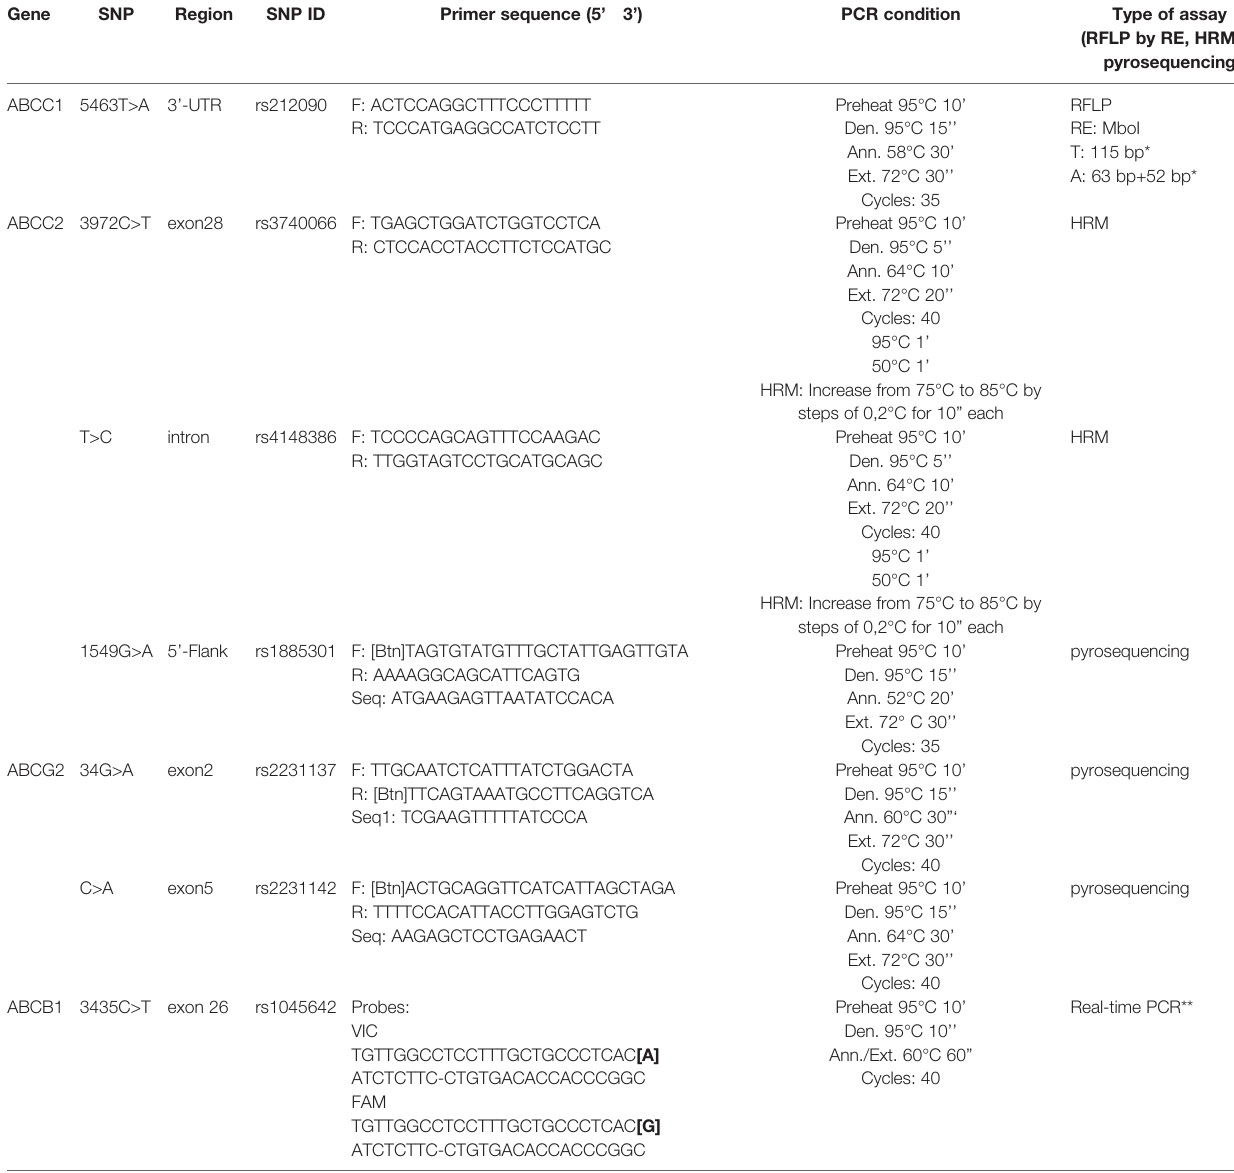
TABLE 1 | SNP, primer sequences and preparative PCR